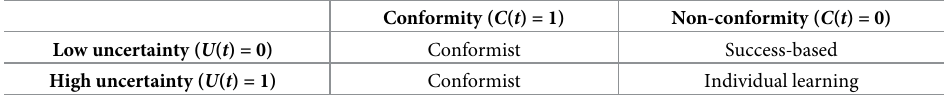
Table 1. The strategies implemented by the SL-EC-Conf-Unc based on the conformity and uncertainty.